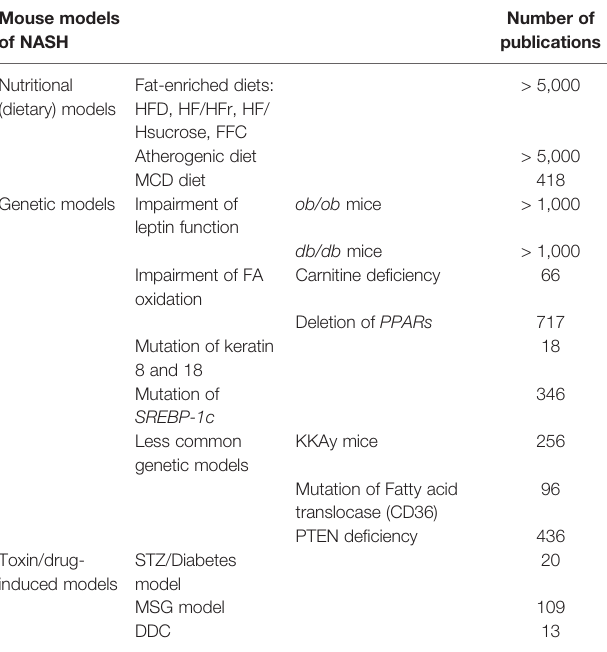
This table represents number of publications found in Pubmed using key words “ name of model and liver and mice ” published between 1950 and